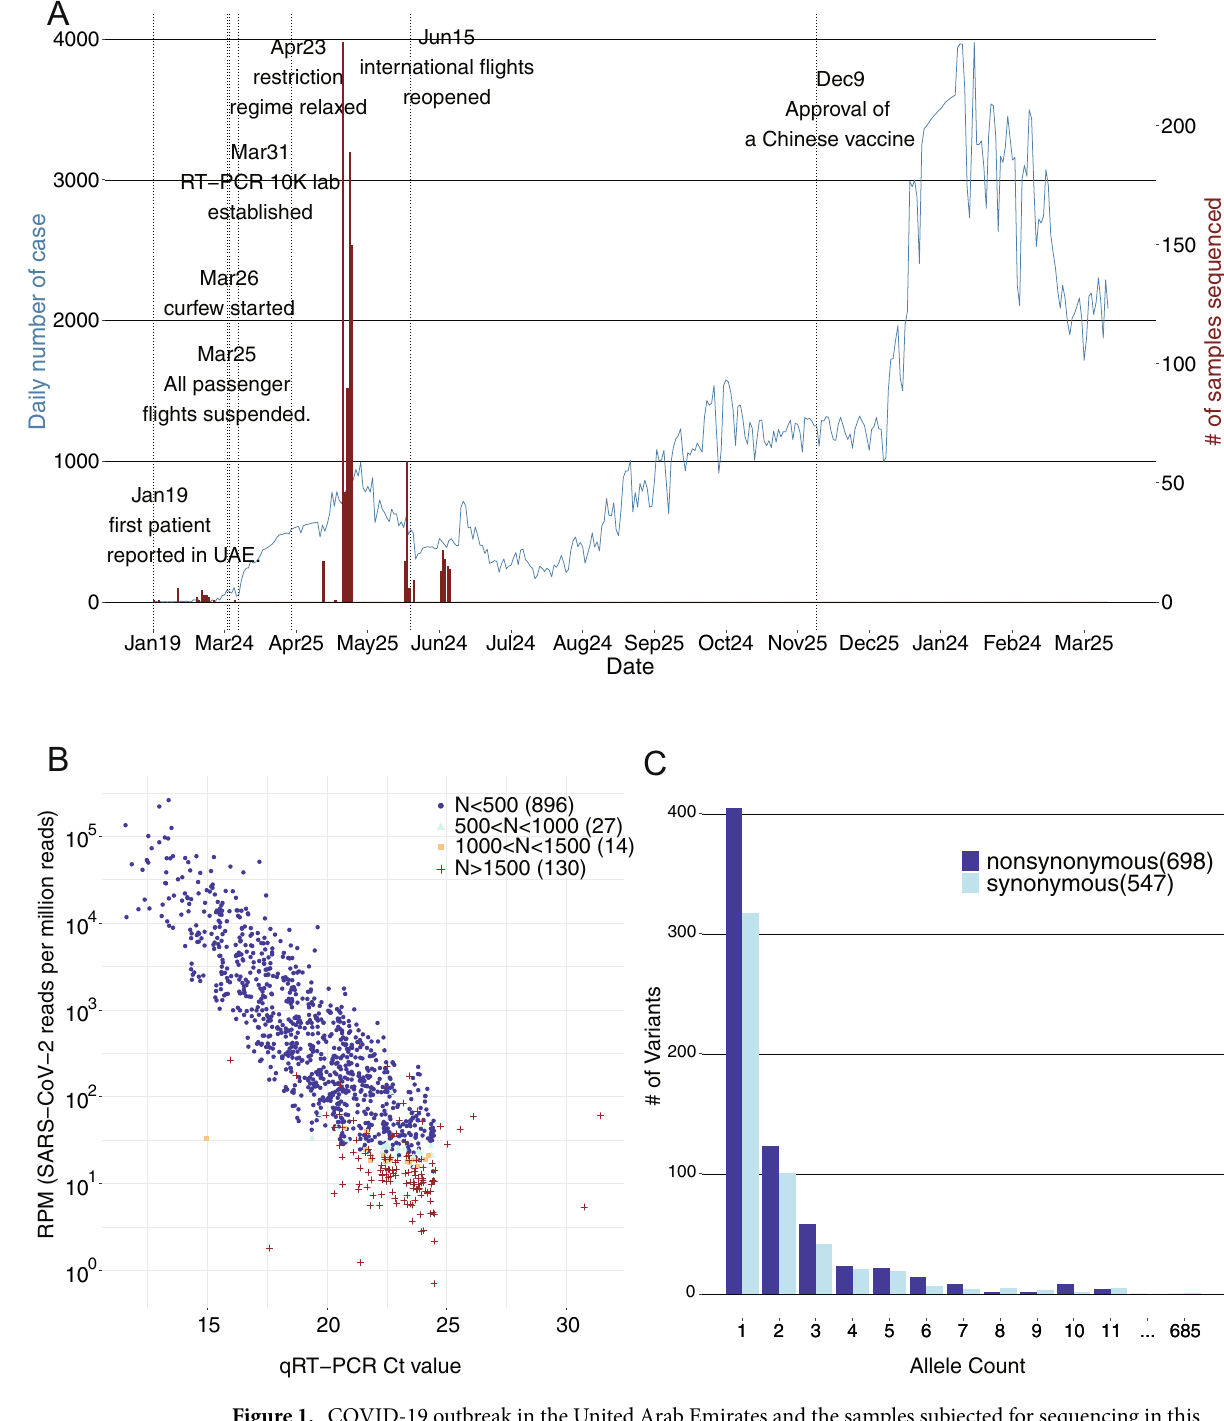
Figure 1. COVID-19 outbreak in the United Arab Emirates and the samples subjected for sequencing in this study. ( A ) Number of confirmed infected cases in the UAE (N = 461,444) until Mar 31st, 2021 was shown in the blue line and the number of subjects sequenced by meta-transcriptomic sequencing (N = 1067) was shown in the red bars. Important dates reflecting governmental responses were marked in black text. ( B ) Assembly quality of the 1067 viral genomes as a function of the RT-PCR Ct value and SARS-CoV-2 reads per million sequencing reads. Color represents assembly quality stratified by the number of gaps. ( C ) Allele frequency spectrum of the 1245 genetic variants identified from the 896 assemblies with less than 2%